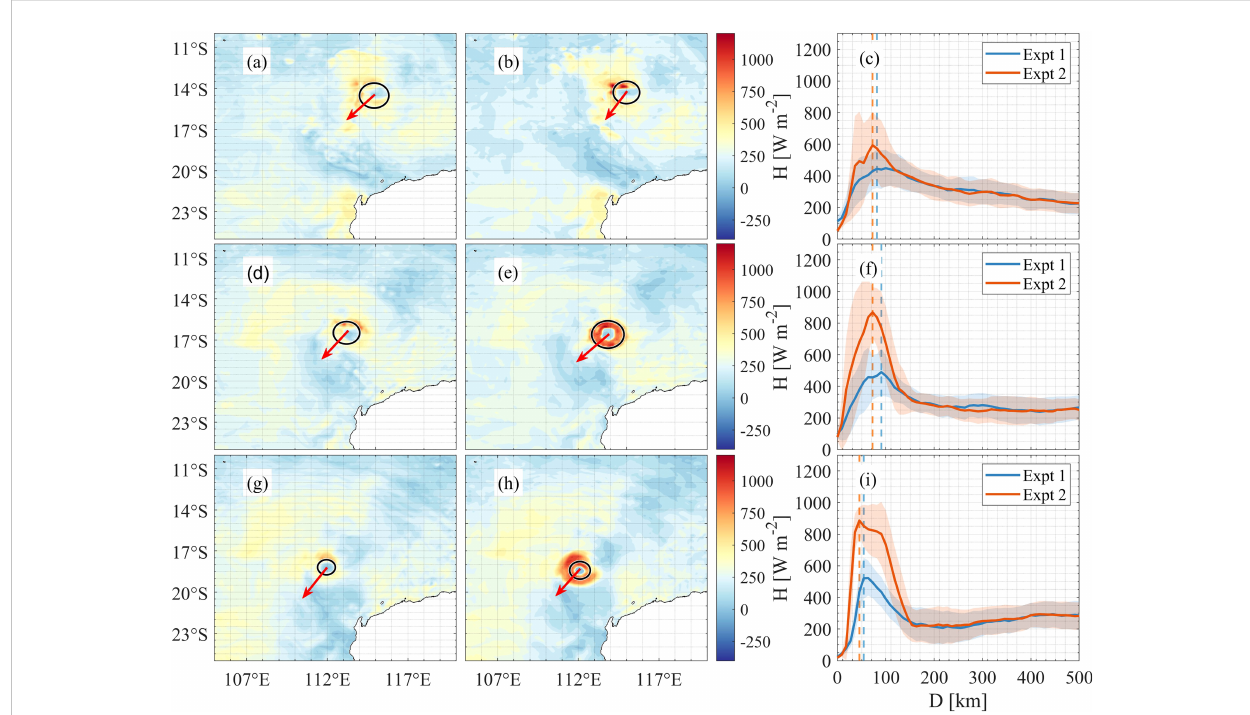
times is demonstrated by the red arrows. The azimuthal averages of the total air-sea heat fl uxes for the simulation results without and with the spume scheme are shown by solid blue and red lines, respectively. The standard deviations of the total air-sea heat fl uxes in all radial directions are represented by shadows. The radius of maximum wind is represented by solid circles and dashed lines in spatial distributions and azimuthal averages,